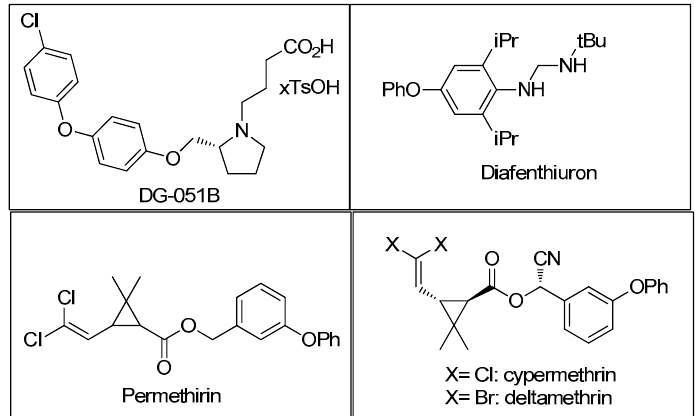
Scheme 41. The scaled-up product used in the